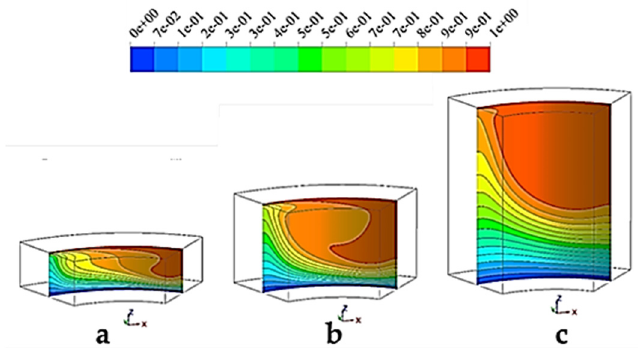
Figure 5. Isotherm lines of the middle plane for different aspect ratios of the cavity at Re = 100, Ra = 1e4, φ = 0%. ( a ) HR = 0.5, ( b ) HR = 1, ( c ) HR = 2.